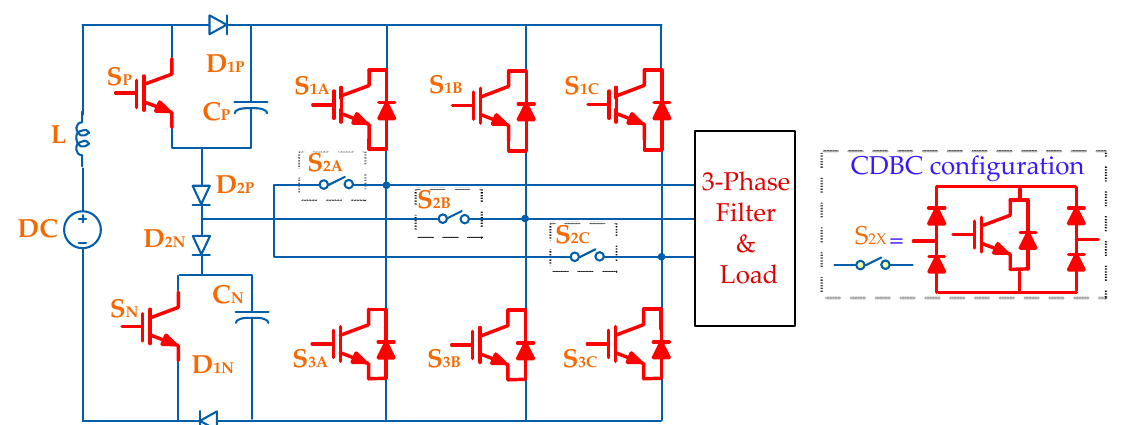
Figure 32. 3L qSBI T-Type inverter with CDBC configuration switch.